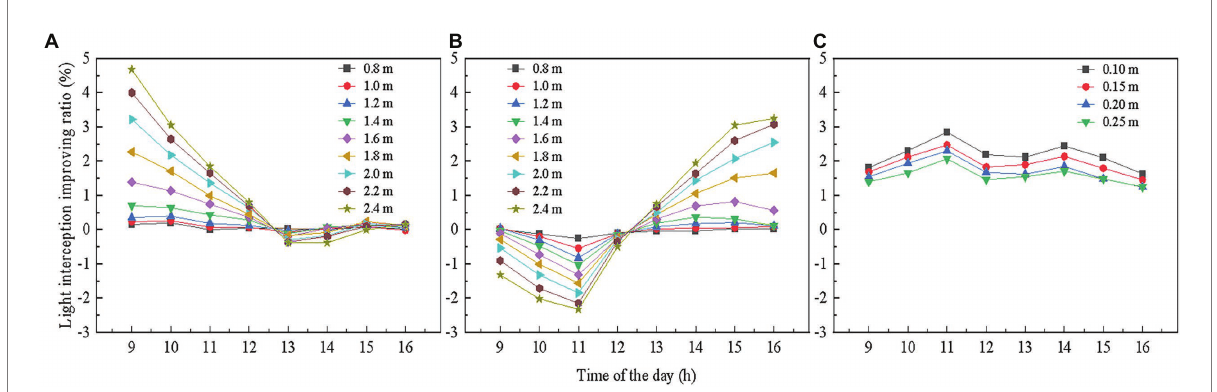
FIGURE 9 Effects of usage time of reflective films with different heights located on (A) the west side, (B) the east side of the greenhouse, and (C) under the canopy on tomato canopy light interception. The reflective films on the west and east sides of the greenhouse were placed on the ground, and the height of the reflective films refers to the length of the reflective films in the vertical direction. The reflective films below the canopy were placed near the plant roots, and the height of the reflective films refers to the height from the ground.